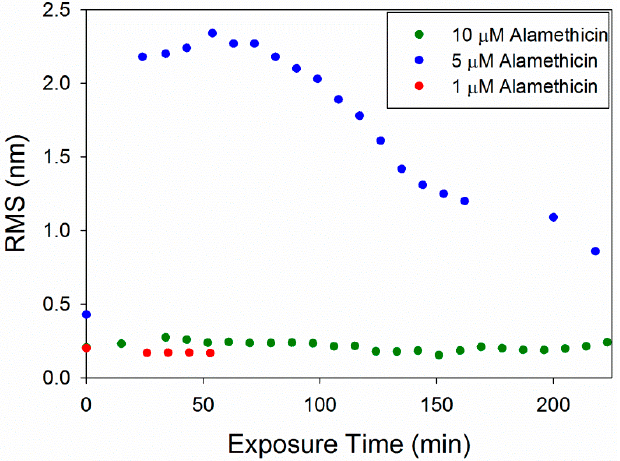
Figure 6. Root mean square (RMS) roughness values calculated for each 5 µ m × 5 µ m image of the Figure 6 . Root mean square (RMS) roughness values calculated for each 5 µm × 5 µm image of the supported PC bilayer after exposure to various alamethicin supported PC bilayer after exposure to various alamethicin concentrations.